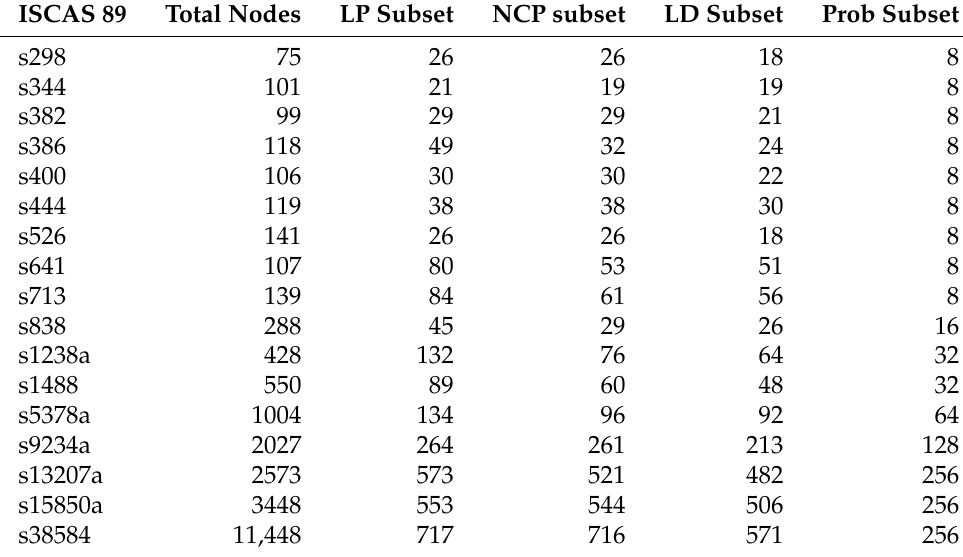
Table 4. ISCAS ’89 Constraint